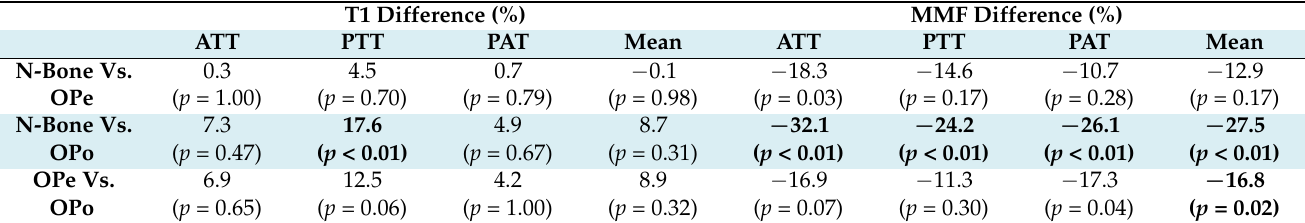
Table 2. Average percentage differences as well as Kruskal–Wallis test results of T1 and MMF between Normal-Bone, OPe, and OPo cohorts. N-Bone label refers to Normal-Bone group. T1 Difference (%) MMF Difference (%) ATT PTT PAT Mean ATT